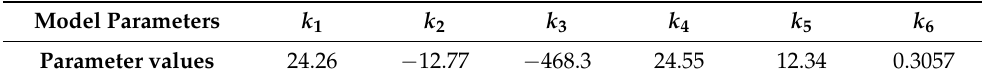
Table 1. Parameter identification results of friction model.